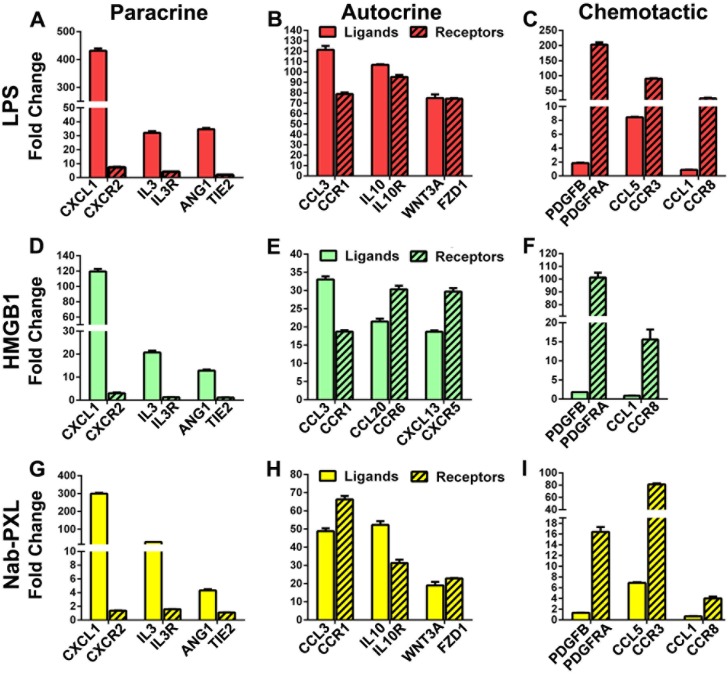
Cytokines upregulated by TLR4 signaling might play autocrine, paracrine and chemotactic roles.Human monocytes differentiated by LPS, HMGB1 and nab-PXL were analyzed by RT-qPCR as described under Methods. Matched pairs of cytokines and receptors were grouped based on expression pattern suggestive of roles in (A, D, G) paracrine, (B, E, H) autocrine, or (C, F, I) chemotactic signaling pathways. Results are plotted as mean fold-change ± S.E.M in CD14+ cells treated with TLR4 ligands as compared with CSF1 alone.